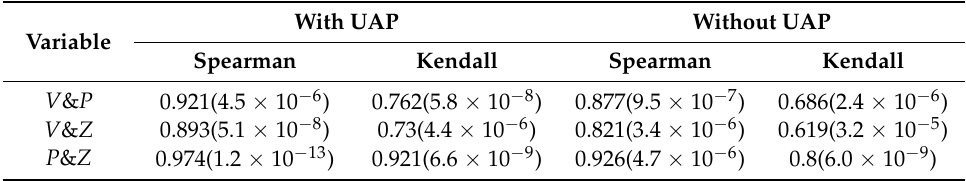
Table A1. Pair-wise dependence between flood